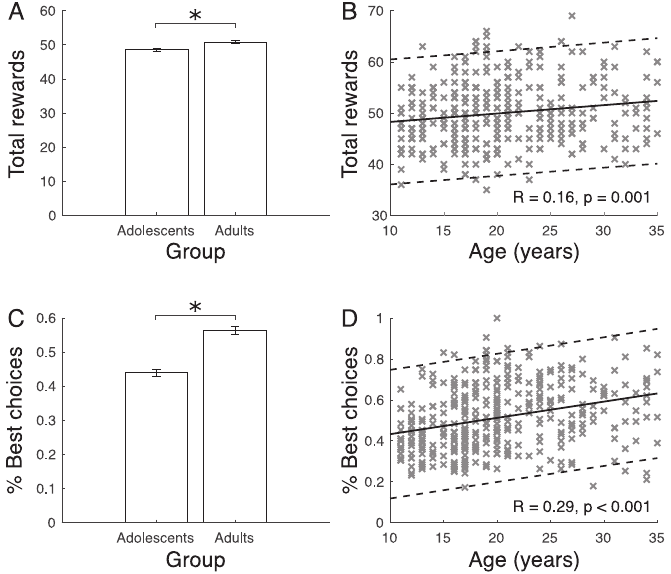
Fig 2. Performance in probabilistic 3-choice learning task increased during adolescence. (A) Young adults, compared to adolescents, earned more total rewards in the study. (B) This was also reflected in a linear increase in the total rewards earned across age. (C) The frequency of choosing the highest value option was higher in young adults. (D) It also increased across age. Note that chance performance in this 3-choice task is 0.33. (“x”s indicate individual participants; left plots show mean − /+ SEM; solid line in the right plots indicate linear trend; dashed line represented 95 th % confidence interval; � p < 0.05). Data for A-D are available in S1 Data (Figure2 tab).